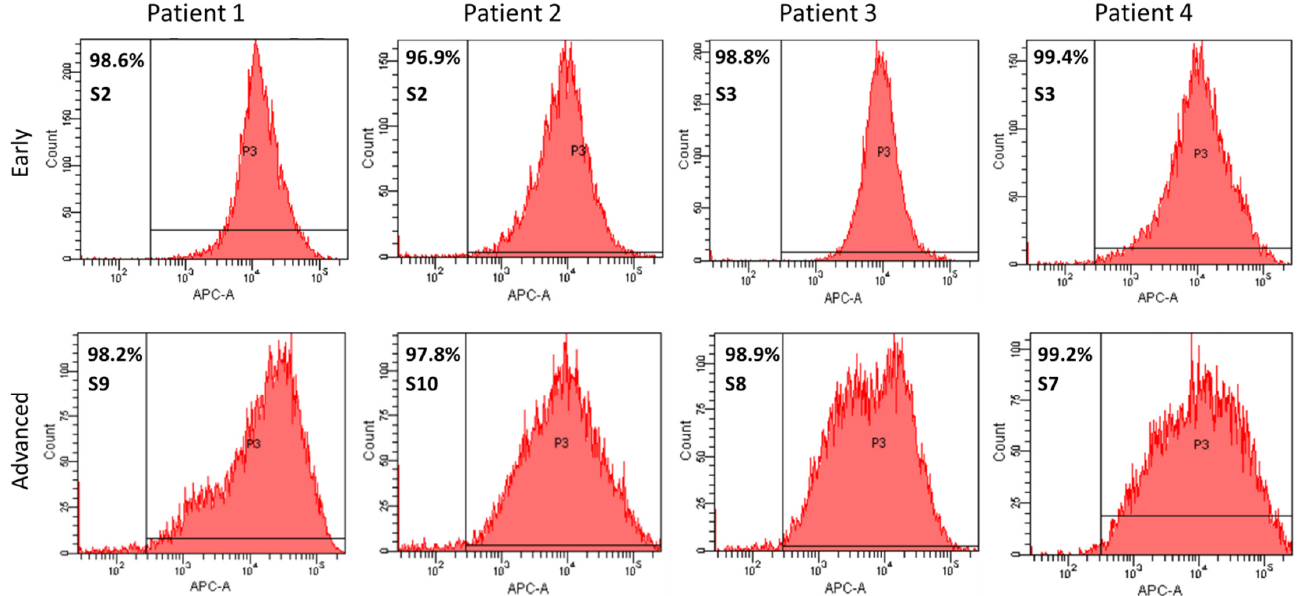
Figure 4. Quantitative phenotyping by flow cytometry of CD31-APC-labeled PAECs isolated from 4 different patients using Swan-Ganz pulmonary arterial catheters. Histograms at early ( upper panel ) and advanced ( lower panel ) subcul- tures.